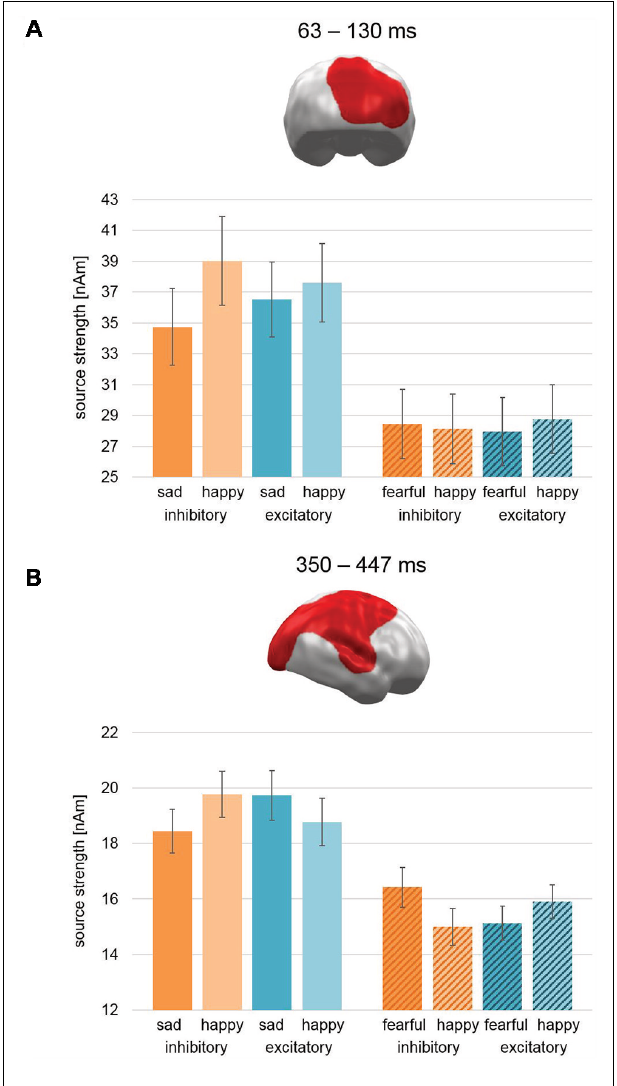
FIGURE 6 | Spatio-temporal clusters with significant three-way interactions of Stimulation × Valence × Study. (A) An early cluster at right occipital cortex regions revealed an effect consistent with our hypothesis for the Happy/Fear study with happy faces showing increased activation compared to fearful faces after excitatory vmPFC-tDCS and vice versa after inhibitory vmPFC-tDCS. For the Happy/Sad study, happy faces showed after both stimulations a relatively higher activation than sad faces, but this difference was relatively smaller after excitatory compared to inhibitory vmPFC-tDCS. (B) Similar to the early latency cluster, the activation pattern in a large late cluster spanning right occipital, parietal, and frontal, as well as superior temporal cortex for the Happy/Fear study was consistent with our hypothesis. However, an exact opposite activation pattern and thus contrary to our hypothesis occurred for study Happy/Sad. It is noteworthy that the spatio-temporal cluster reflects the finding of a two-way interaction consistent with our hypothesis previously reported for Happy/Fear alone (Winker et al., 2018). Bar graph insets indicate standard error of the mean ( ± SEM).